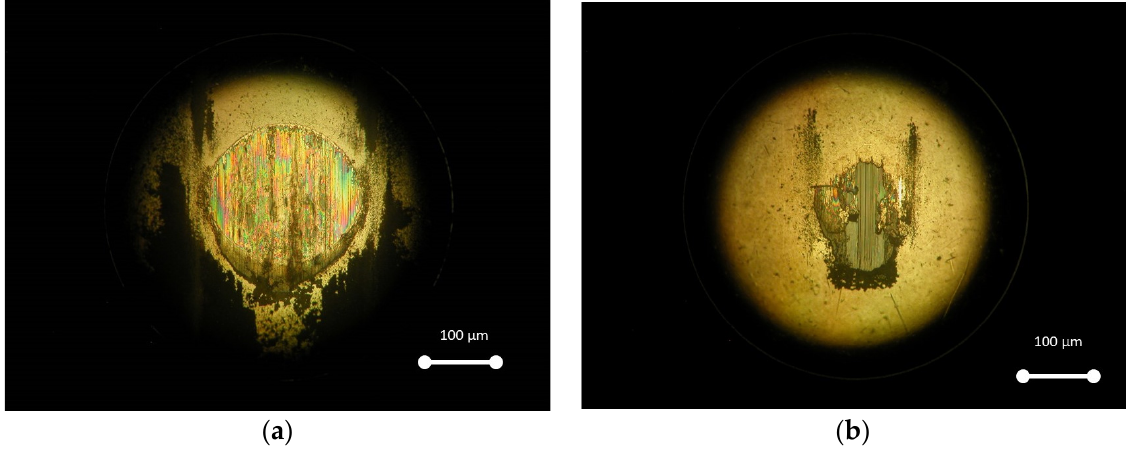
Figure 8. Optical micrograph of the sliding ball after the test with coating deposited with ( a ) 10 sccm of CH 4 , ( b ) 40 sccm of CH 4 .